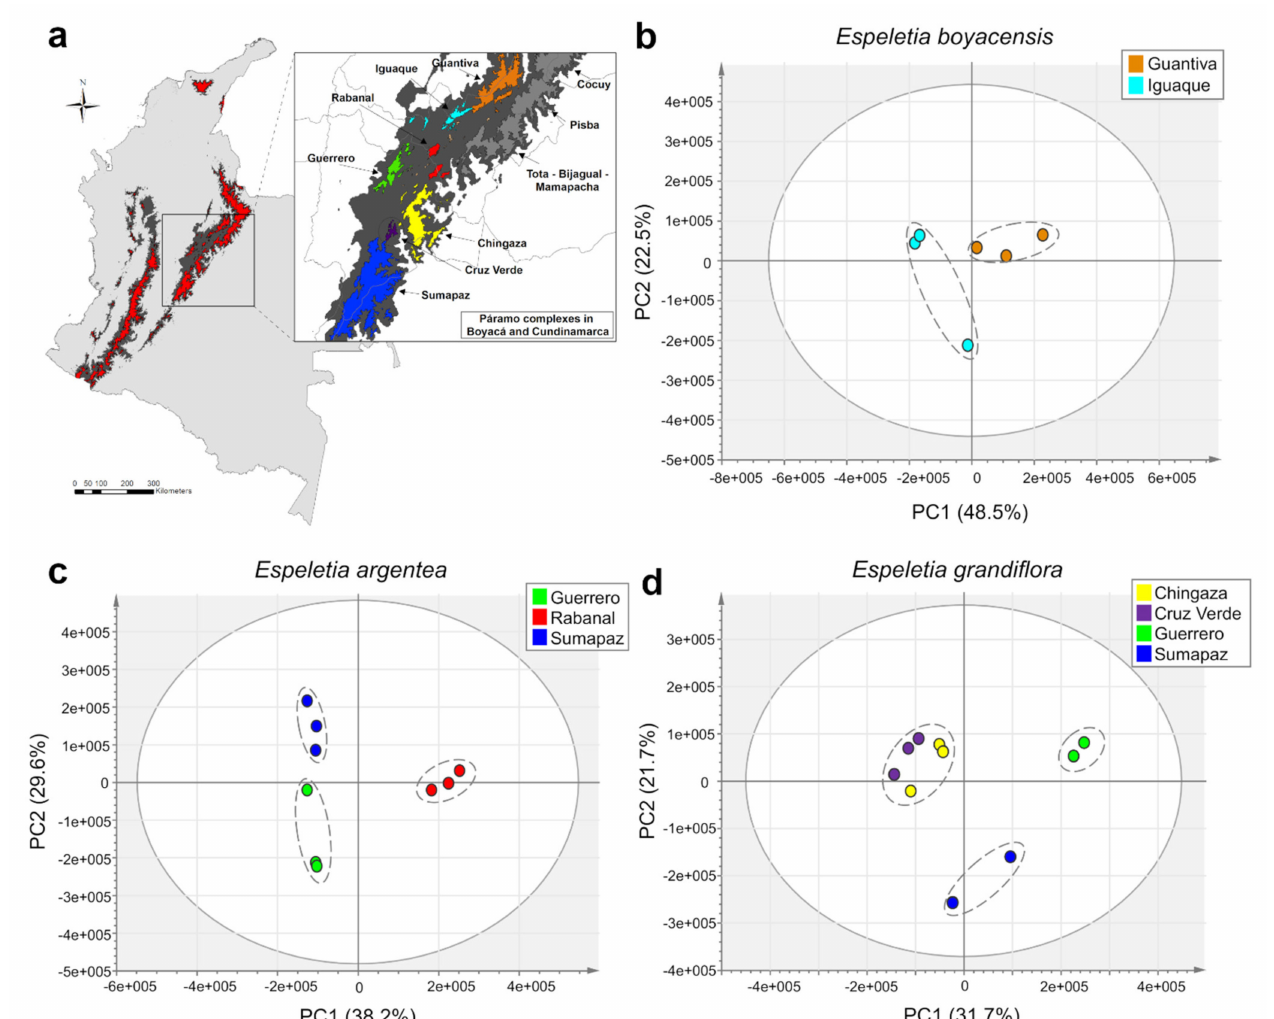
Figure 5. Individual principal component analyses (PCA) based on metabolic fingerprinting in negative ion mode of three species of Espeletia (representing 25 samples and 915 variables). ( a ) Map of Colombia with different p á ramo complexes within the Boyac á and Cundinamarca massifs highlighted in different colors. ( b ) Scores plots showing the metabolic clustering of individuals of E. boyacensis , ( c ) E. argentea, and ( d ) E. grandiflora according to their p á ramo complex of origin. Map created in the software ArcGIS